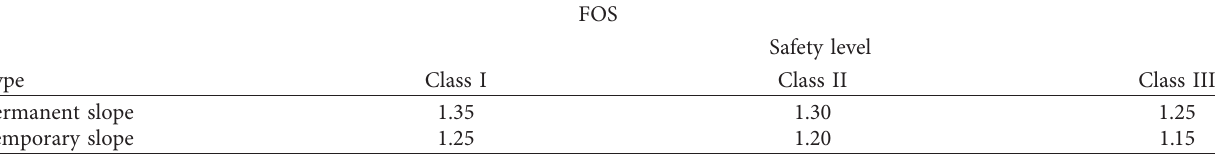
Table 4: Safety factor of F